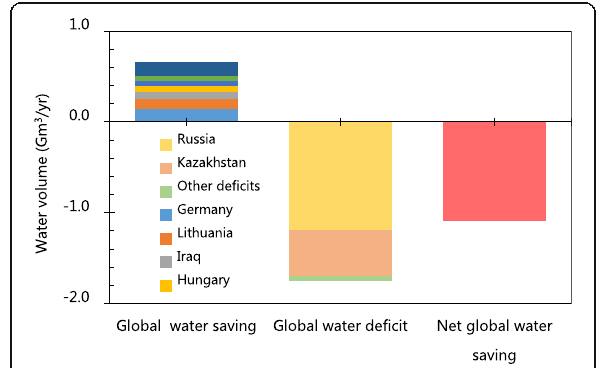
Fig. 10 Comparison of global water saving and deficit regarding the international wheat trade of